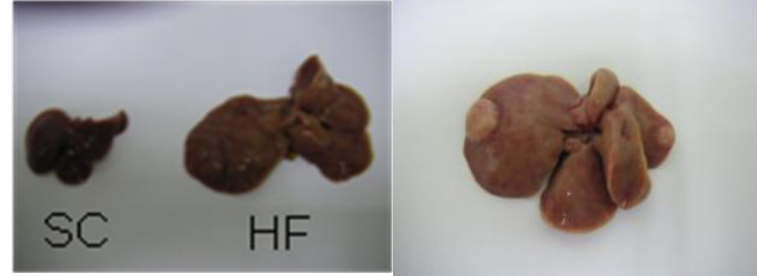
Figure 1. Macroscopic findings in mice fed the standard chow (SC) or high-fat (HF) diet for 60 weeks on the left, and tumors observed on the liver surface in mice fed the HF diet for 60 weeks on the right